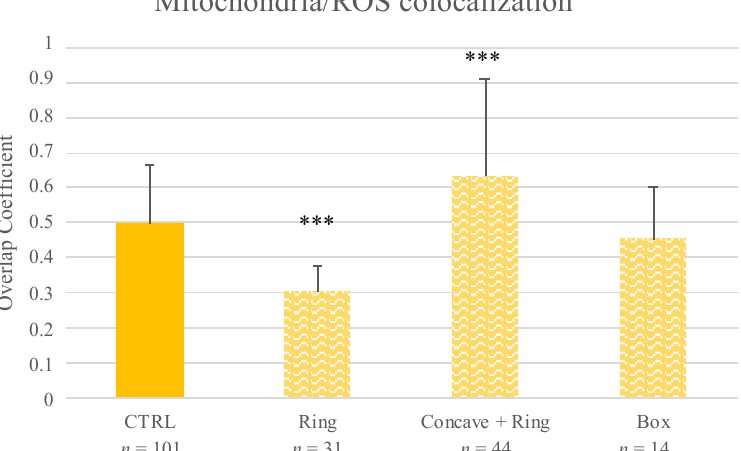
Figure 4. Effects of mIVM with biocompatible (ring; concave + ring; box) supports on mitochondria activity, intracellular ROS levels and mitochondria/ROS colocalization of sheep MII oocytes. Numbers of analyzed matured oocytes are indicated at the bottom of each graph bar. One-way ANOVA, Dunnett’s Multiple Comparison Test: comparisons mIVM versus control *** p < 0.001 .